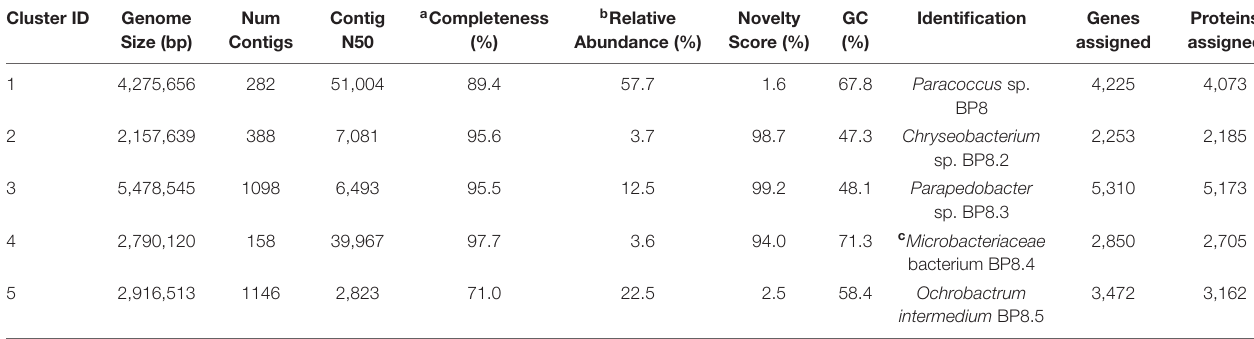
TABLE 2 | General features of the deconvoluted genomes from the BP8 metagenome. Cluster ID Genome